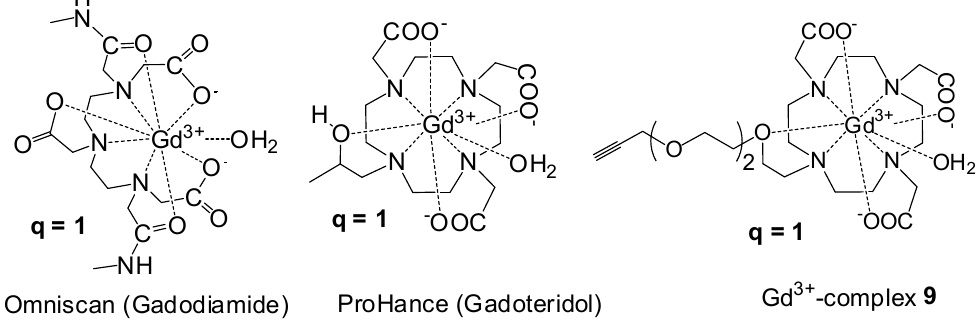
ProHance values of CA-1 , DO3A Gd 3+ -complex 9 with 1